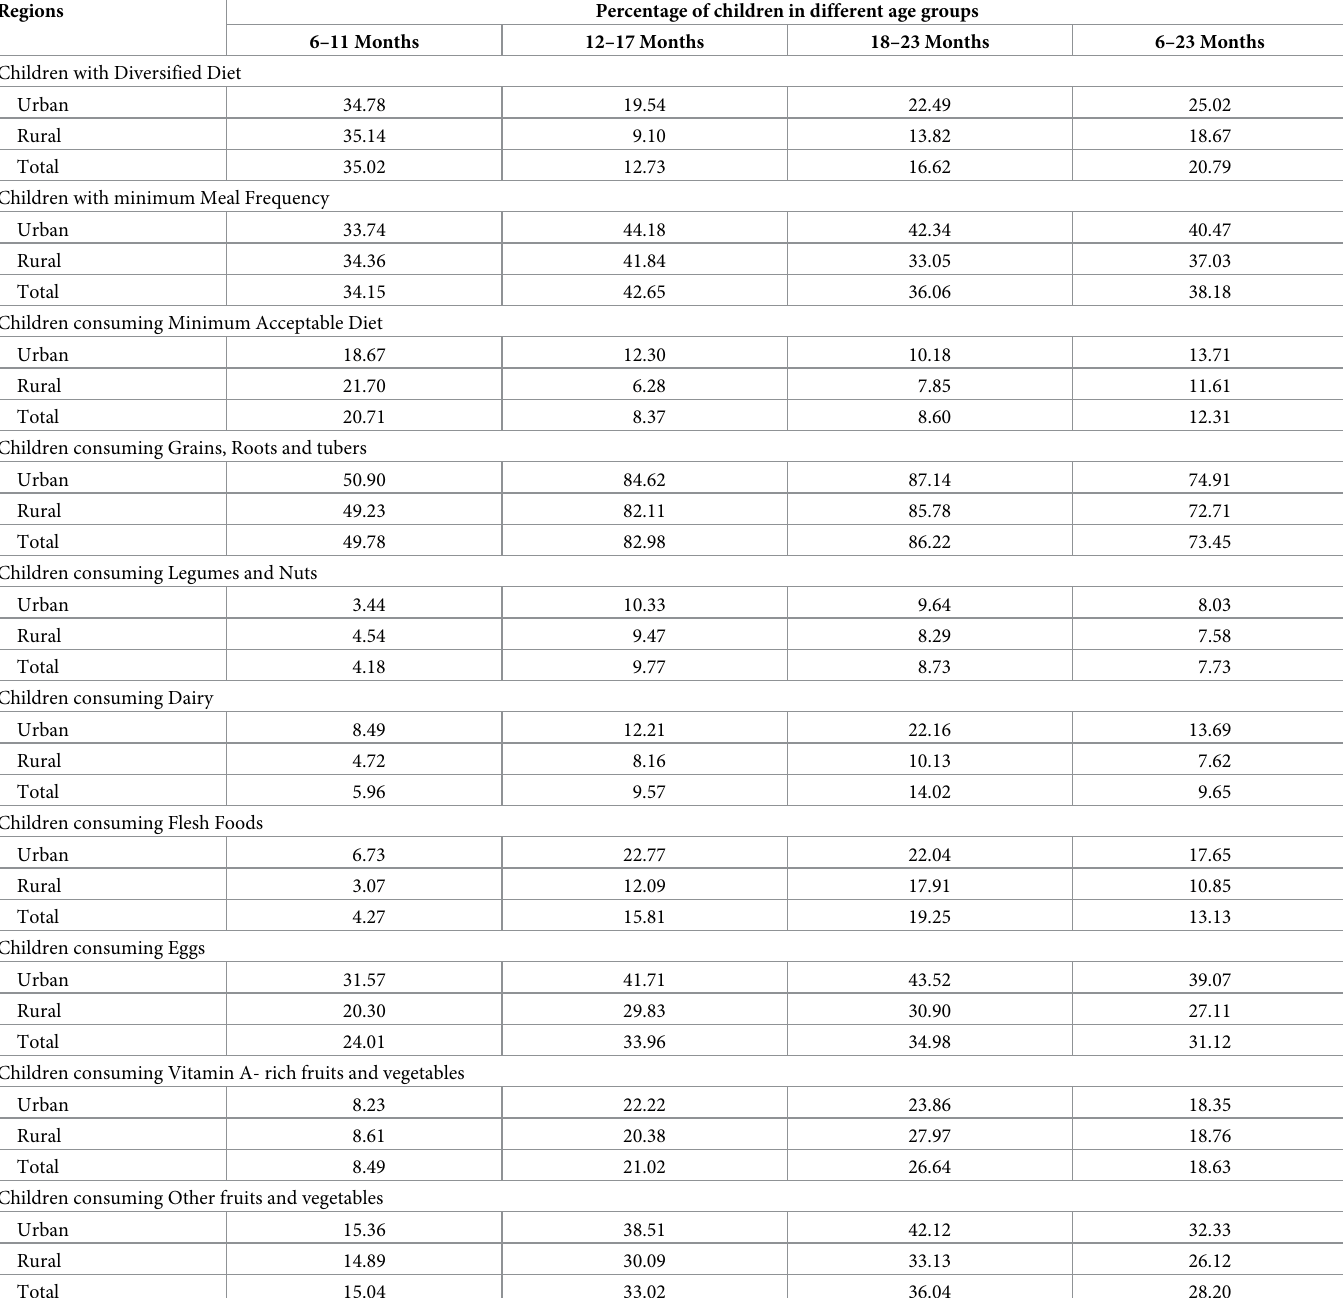
Table 2. Diet diversity, meal frequency, minimum acceptable diet and food group consumption by age and urban-rural areas.